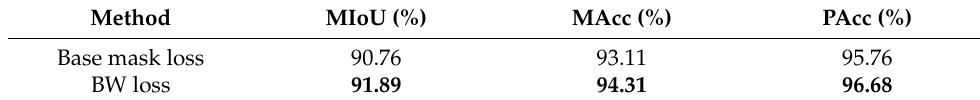
Table 3. Binary mask weighted loss function ablation experiment results.